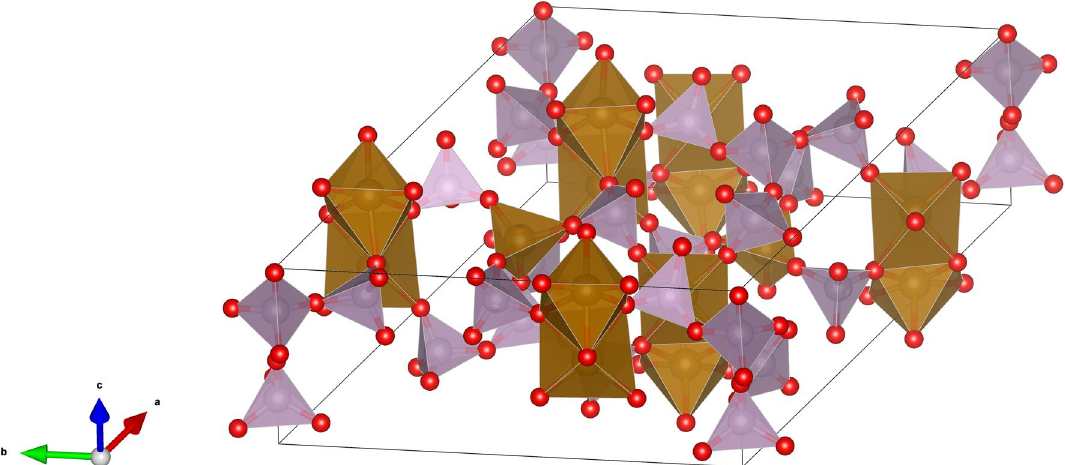
Figure 2. The new Fe 7 P 11 O 38 compound (oxygens are marked in red, phosphorus tetrahedra are purple, and iron polyhedrons are vanadosilicophosphate (V 3 P 5 SiO 19 ) 30 of the P6 3 space group. Since in the devitrified material there is no Si nor V, the atoms were replaced by P and Fe in the following way. All V 3+ ions were replaced by Fe 3+ in their structural positions. Since in the structure there are two inequivalent tetrahedral Si sites, the [SiO 4 ] tetrahedra are joined by a common bridging oxygen. The other oxygen atoms create joints with [PO 4 ] tetrahedra. Thus, one Si 4+ ion was replaced by P 5+ and the other by Fe 3+ . In this way, the [PO 4 ] + tetrahedron is joined to the [FeO 4 ] - tetrahedron to ensure the charge neutrality of the net. The similar connection is characteristic for e.g. rodolicoite. Further- more, the crystal structure parameters and atomic positions were fitted with least squares together with the basic structural parameters of the secondary rodolicoite phase. The fitted (red) and differential patterns (gray) are presented in Fig. 1. The refinement led to χ 2 = 1.25, R w = 0.025. The unit cell parameters of the new compound (Fe 7 P 11 O 38 ) of the hexagonal P6 3 space group No. 173 are a = b = 14.4504(16) Å, c = 7.4261(2) Å. The weight frac- tion of the main compound is 89.5%. It should be noted that the phase stoichiometry (Fe/P = 0.64) is very close to the glass (Fe/P = 0.67). The detailed atom positions, interatomic distances, selected angles, and peaks list are given in the supplementary material (Tables S1–S4), as well as corresponding structural CIF file. The unit cell of the phase is shown in Fig. 2. The main building elements of the structure are [PO 4 ] tetrahedrons, [FeO 6 ] octahedrons that have a common face and create [Fe 2 O 9 ] dimers, and [FeO 4 ] tetrahedrons. For the two phosphorous atoms in the Wycoff 6c posi- tions, the [PO